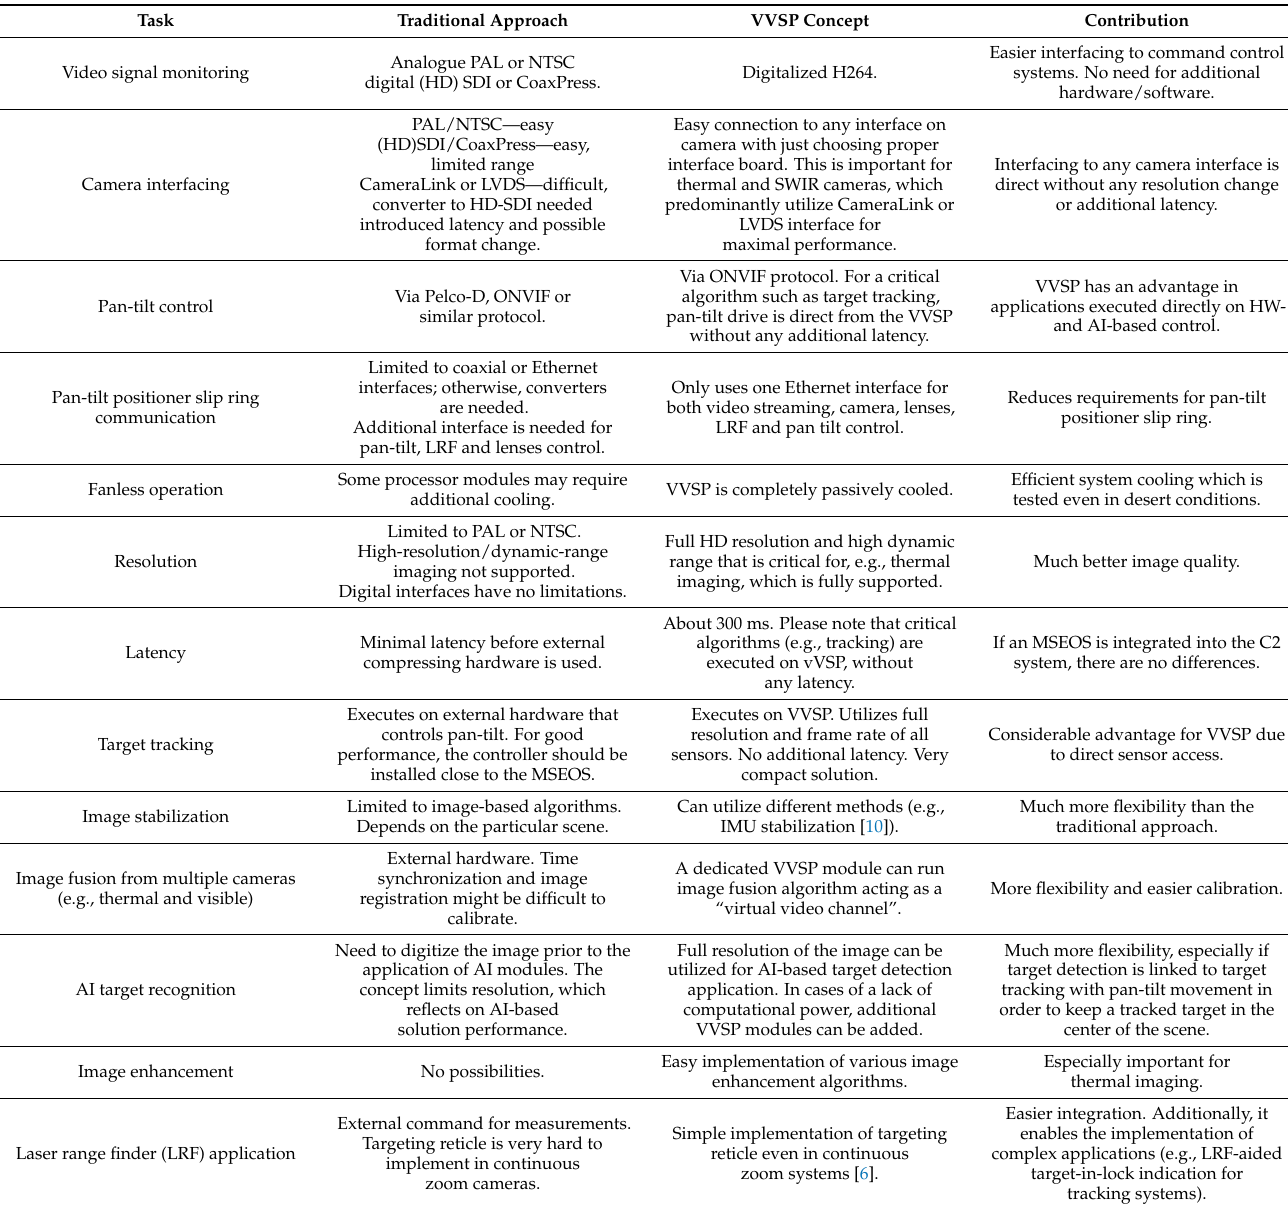
Table 2. VVSP concept contribution vs. traditional concept